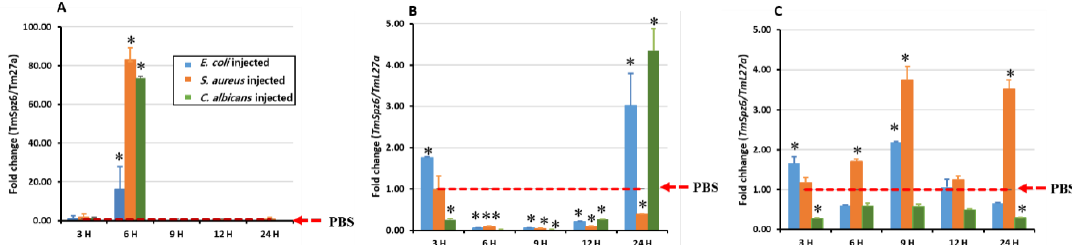
Figure 4. Induction patterns of TmSpz6 expression in di ff erent T. molitor larval tissues. The temporal expression of TmSpz6 was analyzed in the hemocytes ( A ), gut ( B ), and fat body ( C ) of young larvae at 3, 6, 9, 12, and 24 h post-injection of E. coli (10 6 cells / µ L), S. aureus (10 6 cells / µ L), and C. albicans (5 × 10 4 cells / µ L). Twenty young larvae were used at each time point. TmSpz6 expression levels were normalized to those in 1X phosphate-bu ff ered saline (1X PBS)-injected controls. T. molitor 60S ribosomal protein L27a ( TmL27a ) was used as an internal control. The asterisks indicate significant di ff erences ( p ≤ 0.05).